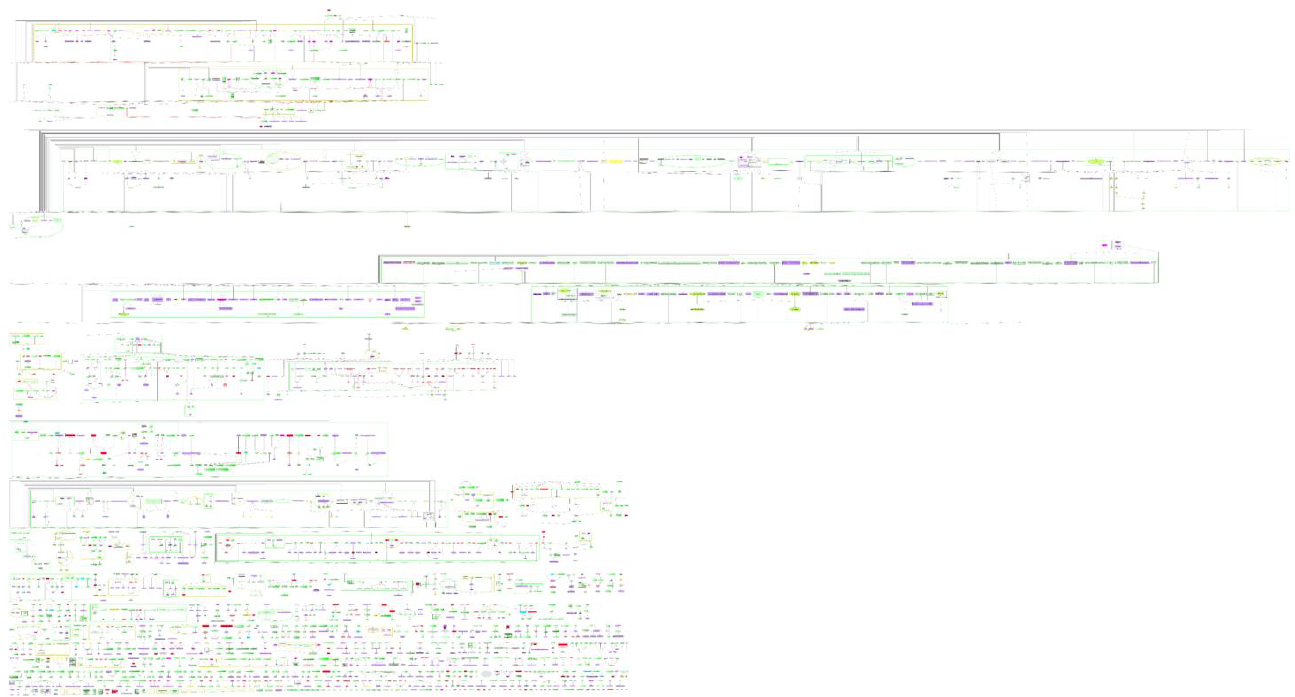
Figure 1. The network of the comprehensive molecular map which includes 1756 genes and 3109 proteins related to T. cruzi . The network is generated using CellDesigner v.4.4.2. Since the figure is the user to download and view